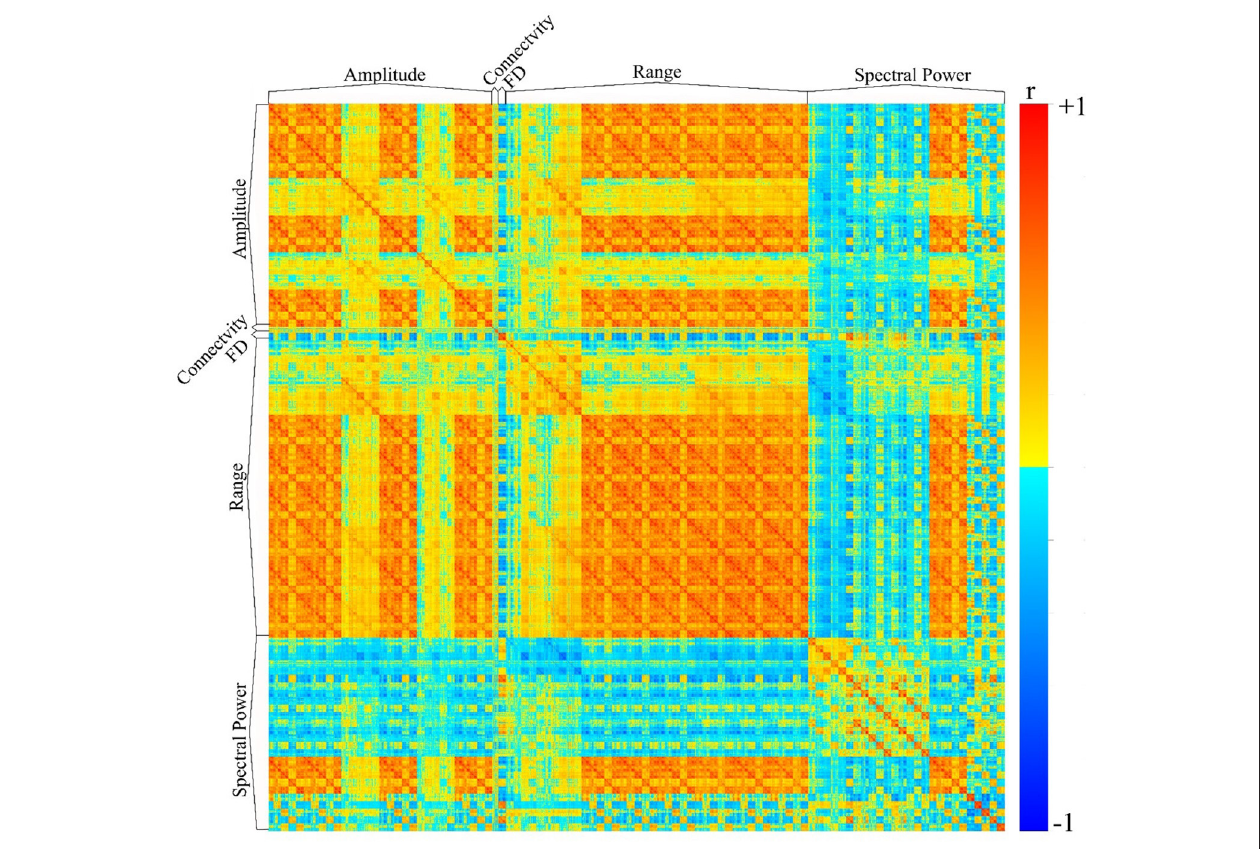
FIGURE 6 | The correlation matrix of 3,032 EEG features extracted using comprehensive EEG features extraction for resting-state condition. Five different subsets of features were extracted including Amplitude (31 Channels × 5 bands × 6 types = 930 features), connectivity (24 features), FD (31 Channels × 1 Feature = 31), range (31 Channels × 5 bands × 8 types = 1240 features) and spectral power features (31 Channels × 5 bands × 5 types + 31 Channels × 1 Feature = 806 features). For more details about each subset of features, please see